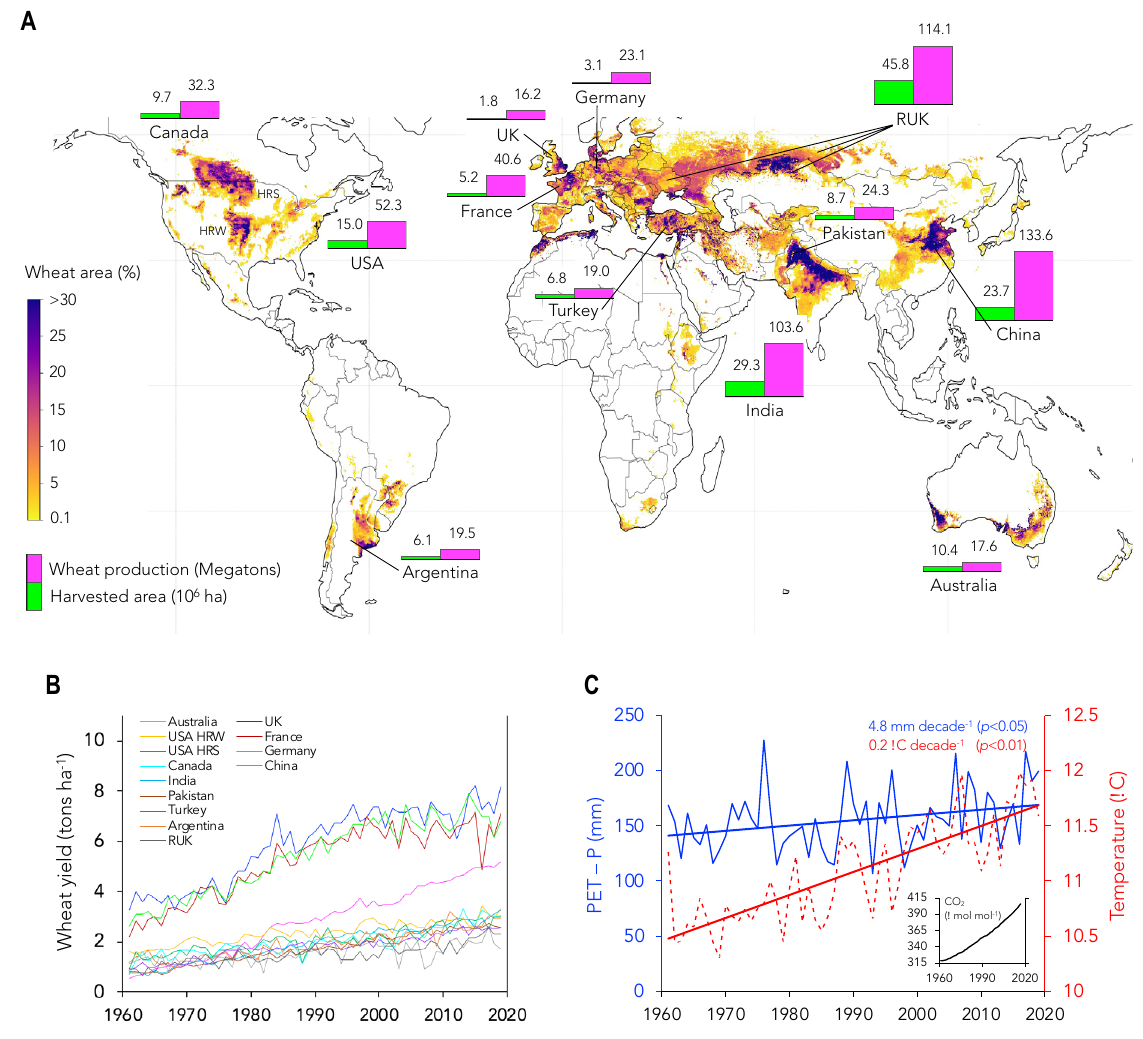
Figure 1. Global wheat area and trends in wheat yield and climate in top-twelve global wheat producers (1961–2019). ( A ) Worldwide wheat cropping area (%) 29 , total harvested area (10 6 hectares in 2019), and wheat production (megatons for 2019) of the top 12 global wheat producers (China, RUK—Russia, Ukraine, and Kazakhstan, India, USA—hard red winter (HRW) and hard red spring (HRS), France, Canada, Pakistan, Germany, Argentina, Turkey, Australia, and United Kingdom) (Map was generated in Python 3.8.5; http:// www. python. org). ( B ) Changes in wheat yield (tons per hectare) and ( C ) climate—mean daily temperature (red dashed line; °C) and the seasonal water balance represented as potential evaporation minus precipitation (blue line; PET—P in millimeters of H 2 O). A positive trend in PET-P indicates an increase in water deficit. The seasonal atmospheric [CO 2 ] in μmol CO 2 per mol −1 air is also shown in the insert of C (black line). Temperature, PET-P, and [CO 2 ] shown in C are averaged values over the wheat-growing period and the shared area of the wheat-growing areas of the top 12 global wheat producers. Decadal trends in temperature (red) and PET-P (blue) as well as the significance levels of these trends are presented in C